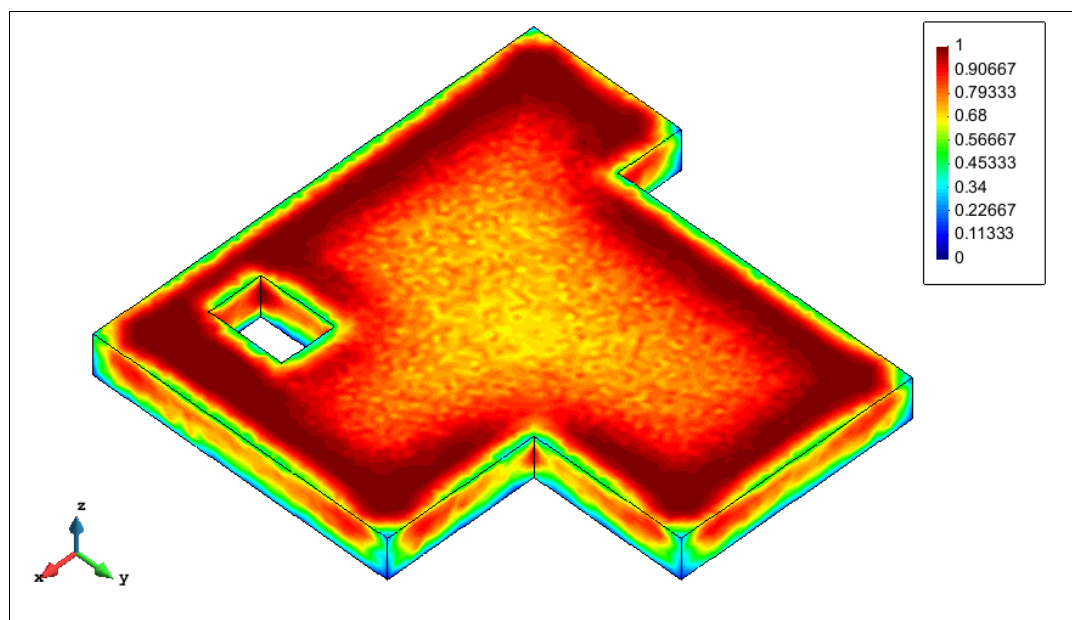
Figure 11. Cracking index field for the structure with the minimal